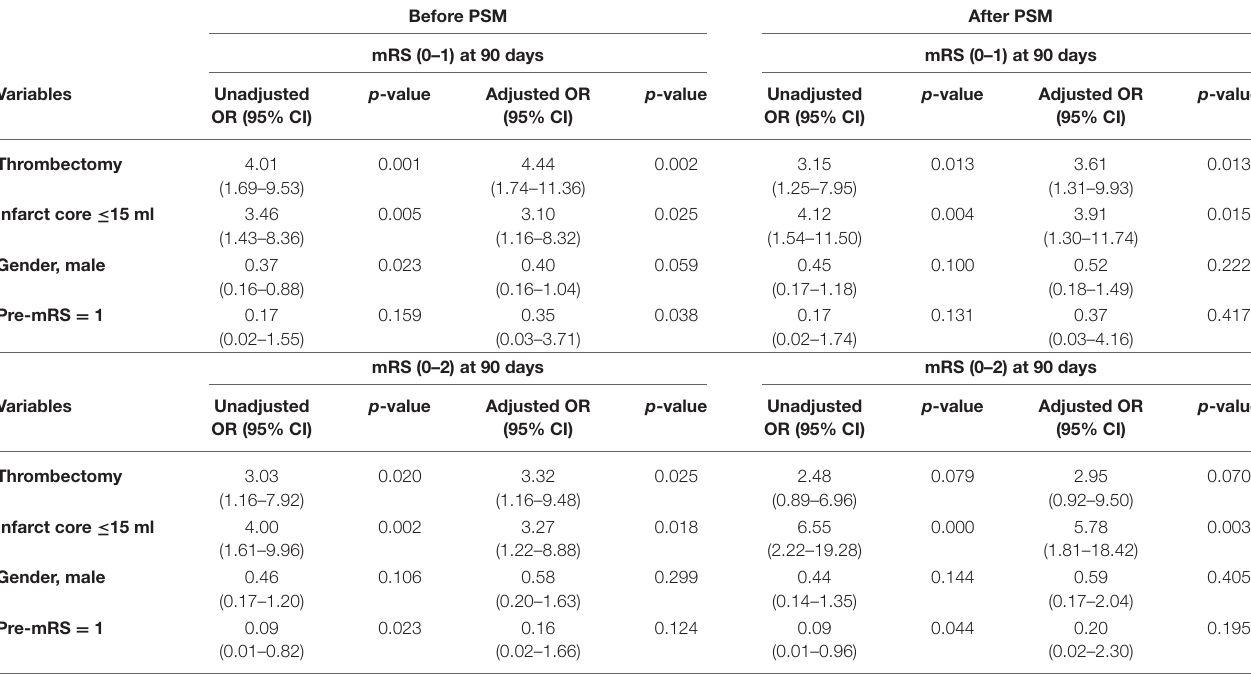
TABLE 3 | Univariate and multivariate analysis of determinants of good outcome before and after PSM. Before PSM After